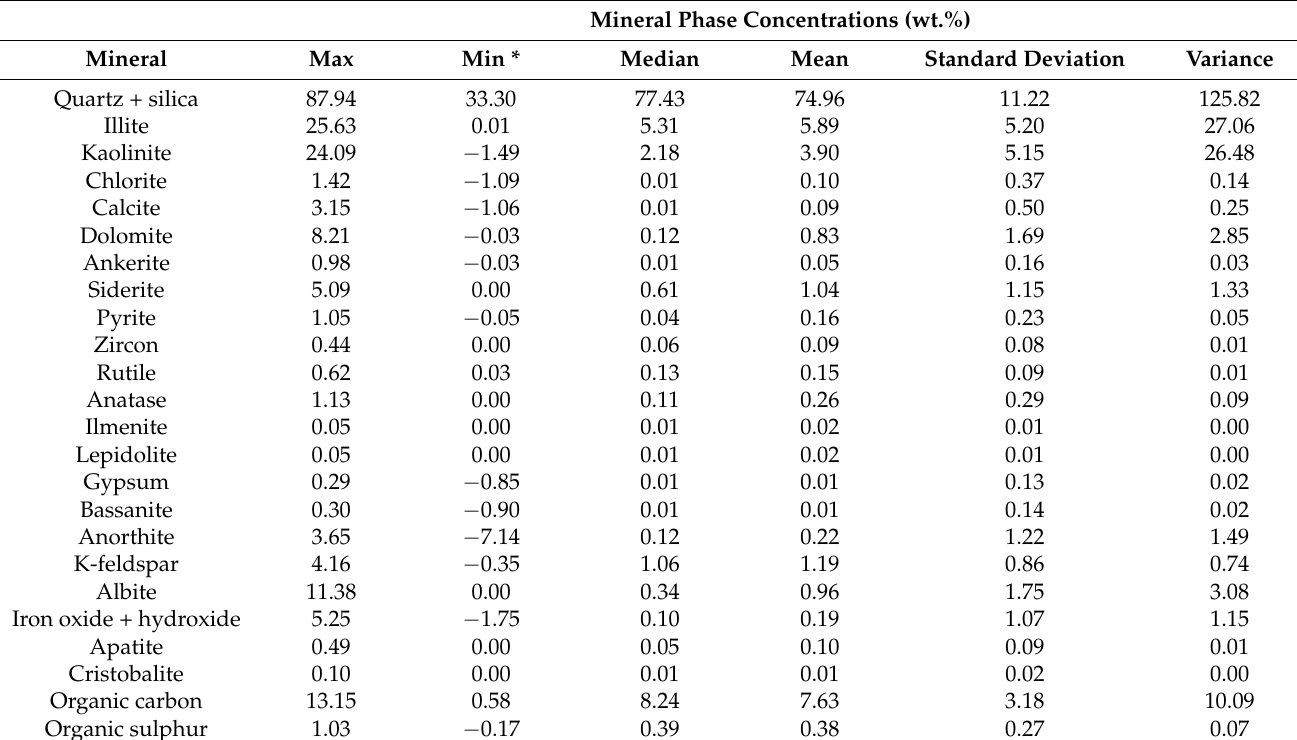
Table 1. Summary of descriptive statistics for mineral phases analyzed by X-ray diffraction (XRD) in 60 samples. Mineral Phase Concentrations